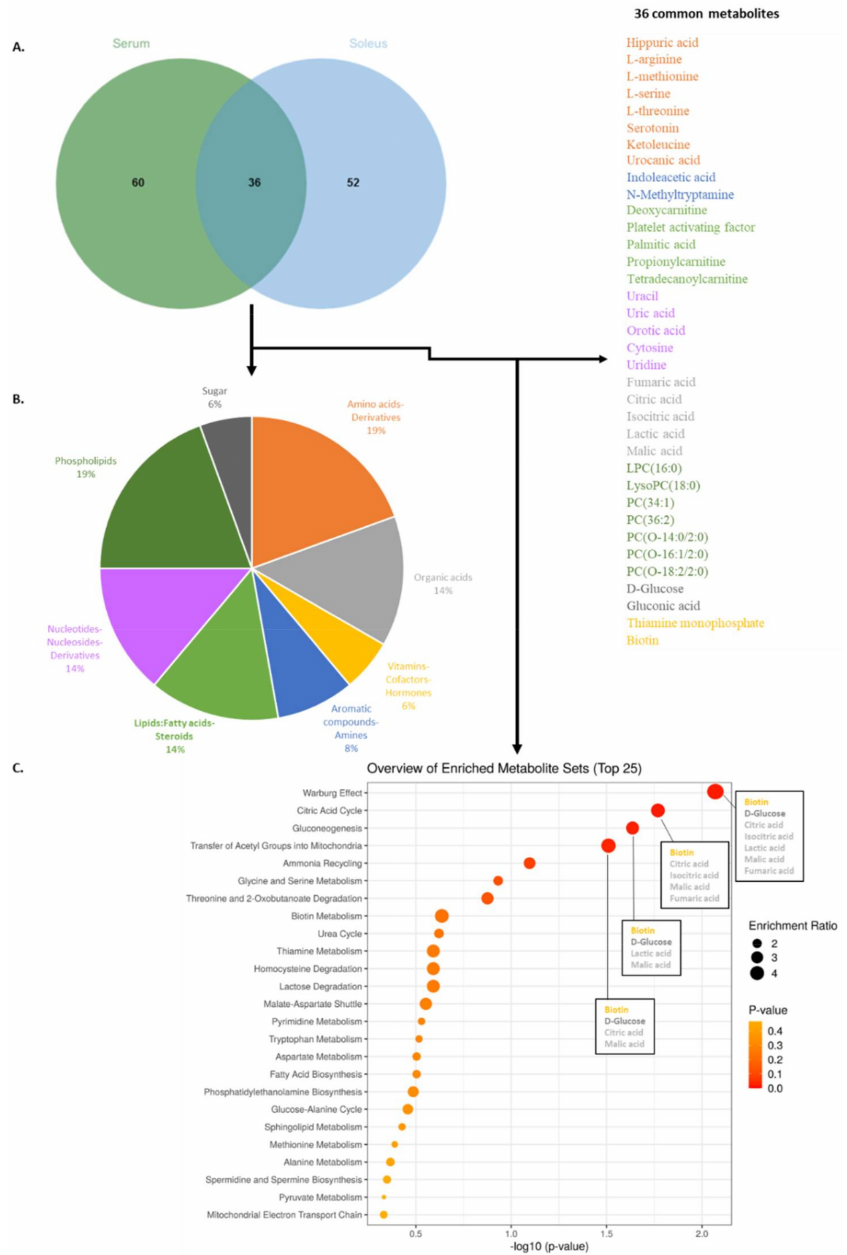
Figure 6. Venn diagram ( A ), pie chart of chemical metabolite repartition ( B ), and MSEA of the 36 metabolites common between serum and soleus ( C ). ( A ) Venn diagram using the 96 VIP from serum and the 88 VIP from soleus were generated and found 36 common metabolites across the two matrices. A list of the common metabolites found both in serum and soleus is given on the right panel of the figure. ( B ) Pie chart using the 36 common metabolites found in the Venn intersection assigned compounds into chemical classes. ( C ) Overview of enriched metabolites sets (bubble plot) that shows the 25 top pathways related to the common 36 metabolites identified both in serum and soleus. For the first four pathways, name of common VIP is in the square plot, colors refer, respectively, to their chemical category. p -value is given by red color spot